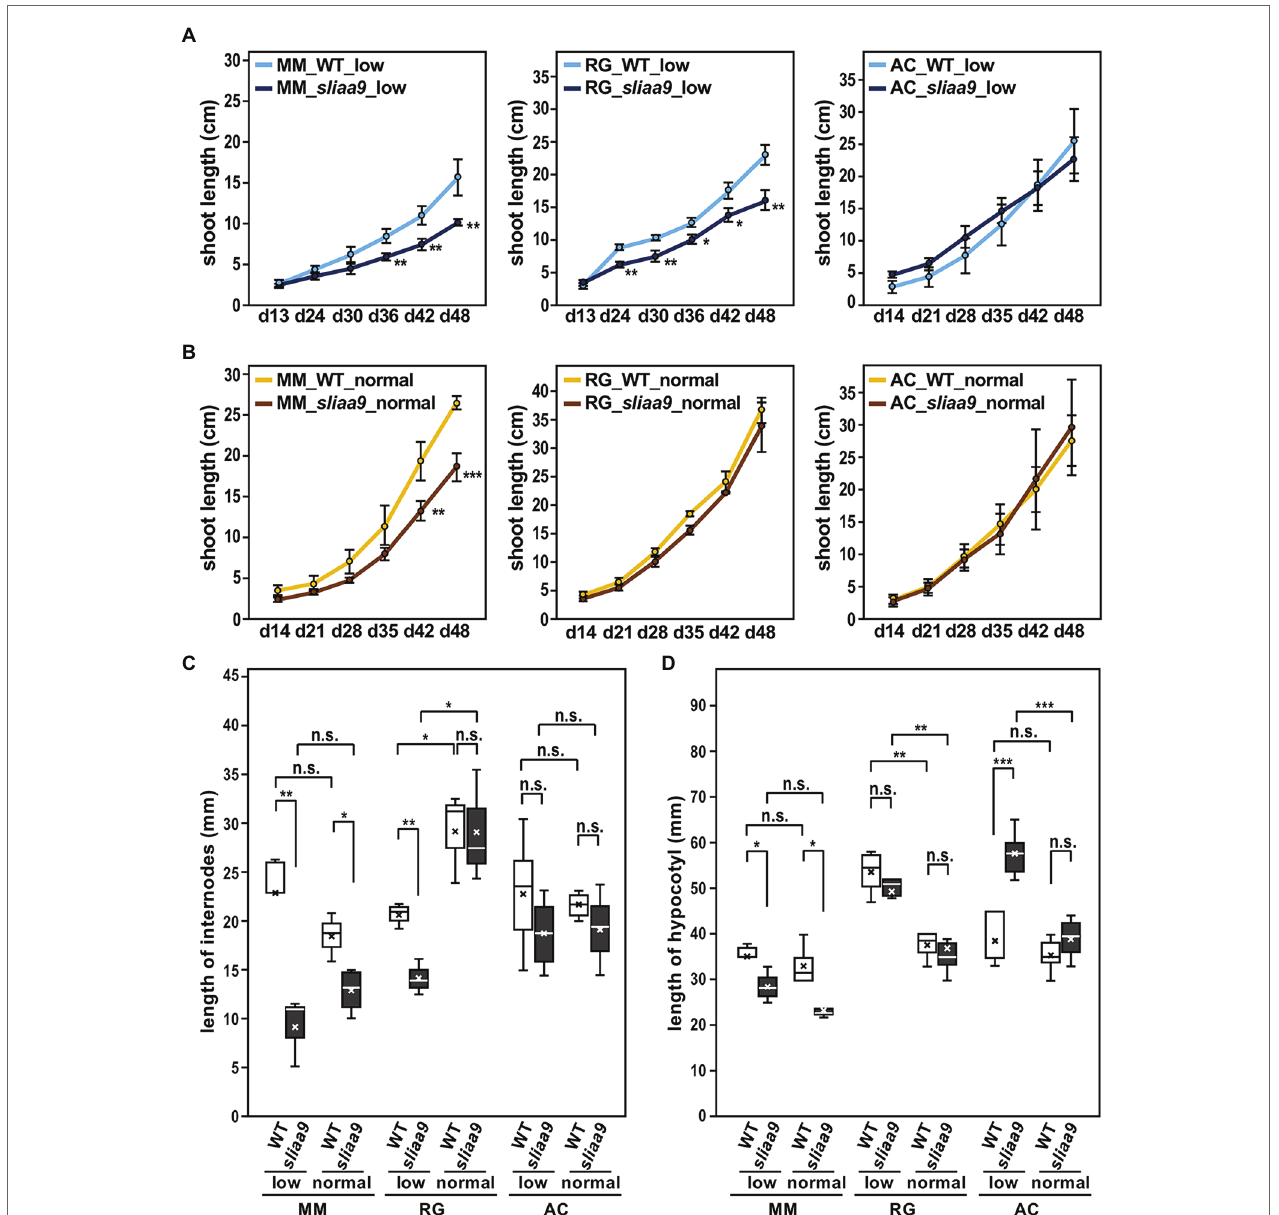
FIGURE 2 | Elongation growth of stem/hypocotyl in the sliaa9 mutants under different light conditions. (A) Shoot growth rates of sliaa9 mutants and the wild-type under low light conditions. (B) Shoot growth rates of sliaa9 mutants and the wild-type under normal light conditions. (C) Length of 3rd–10th internodes of the sliaa9 mutants and the wild-type at day 48. (D) Hypocotyl length of young seedlings of sliaa9 mutants and the wild-type at day 21. MM; Moneymaker, RG; Rio Grande, AC, Ailsa Craig. T2 lines from MM#2-13, RG#4-1, and AC#1-1 (T1 lines) were analyzed. Data are means ± S.D. of independent T2 plant lines ( n = 3–6). low; grown in low light conditions, normal; grown in normal light conditions. * p < 0.05, ** p < 0.01, and *** p < 0.001 are determined by Student’s t tests. n.s., not